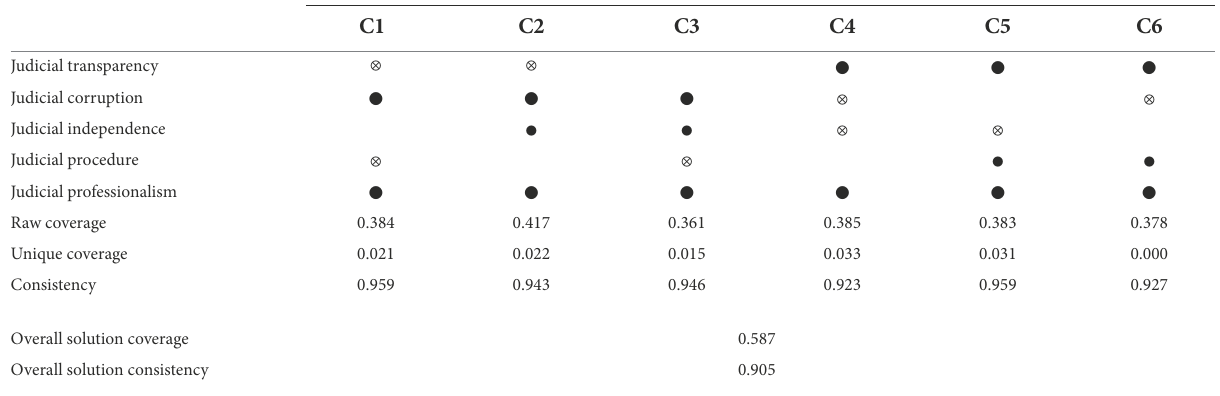
TABLE 4 Results of fuzzy